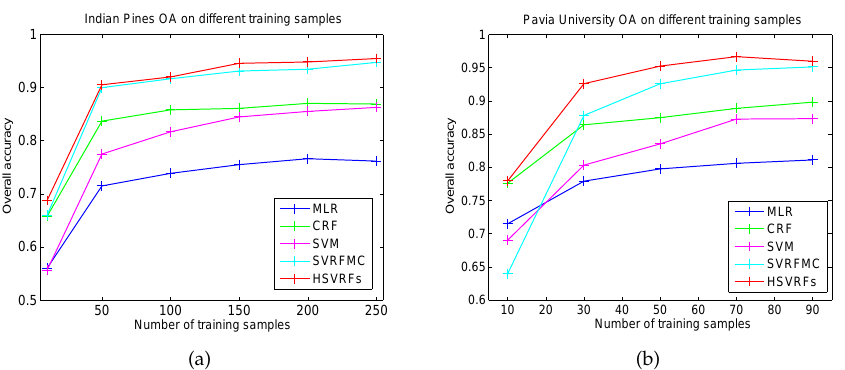
Figure 5. Overall classification accuracies with different numbers of training samples. ( a , b ) show the OA versus different numbers of training samples on the Indian Pines and Pavia University datasets,